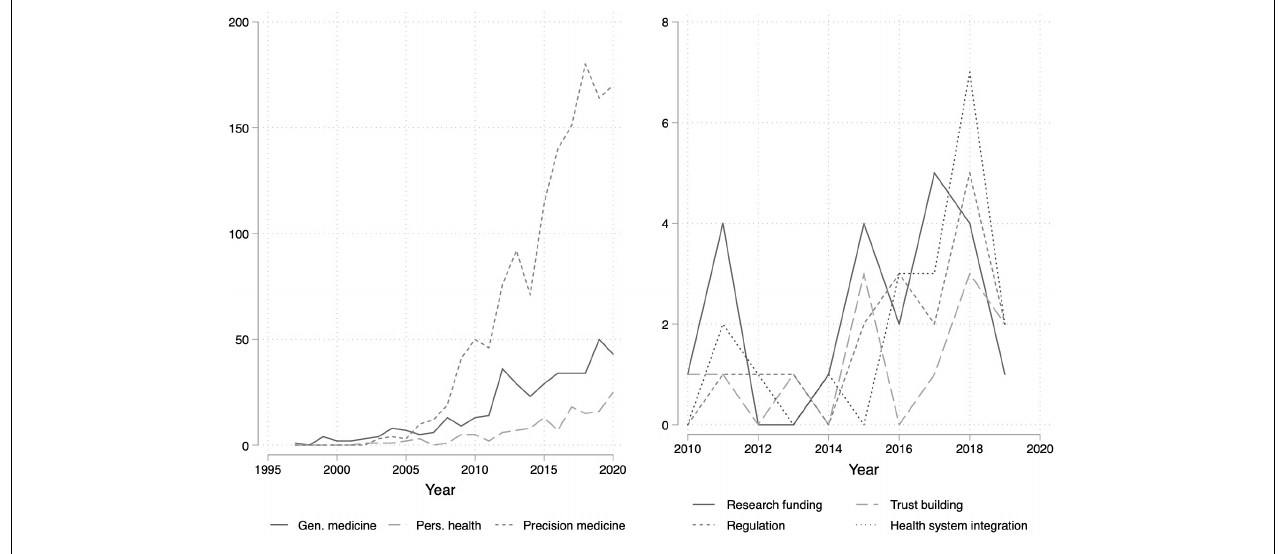
FIGURE 2 | Development of publications over time.